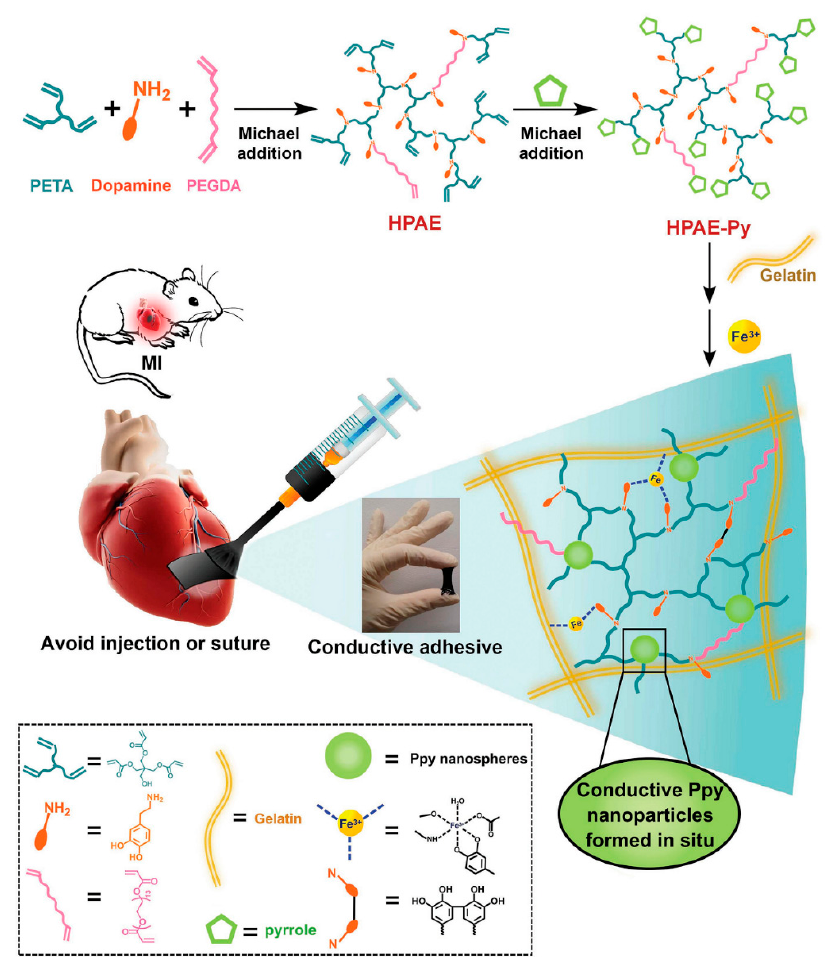
Figure 8. Conductive adhesive hydrogel patches synthesis attached on myocardial infarction (MI) site. Pyrrole was capped dopamine, simultaneously polymerized using Fe 3+ oxidation which acted as an adhesive and conductive substrate [202], copyright John Wiley and Sons, 2018.